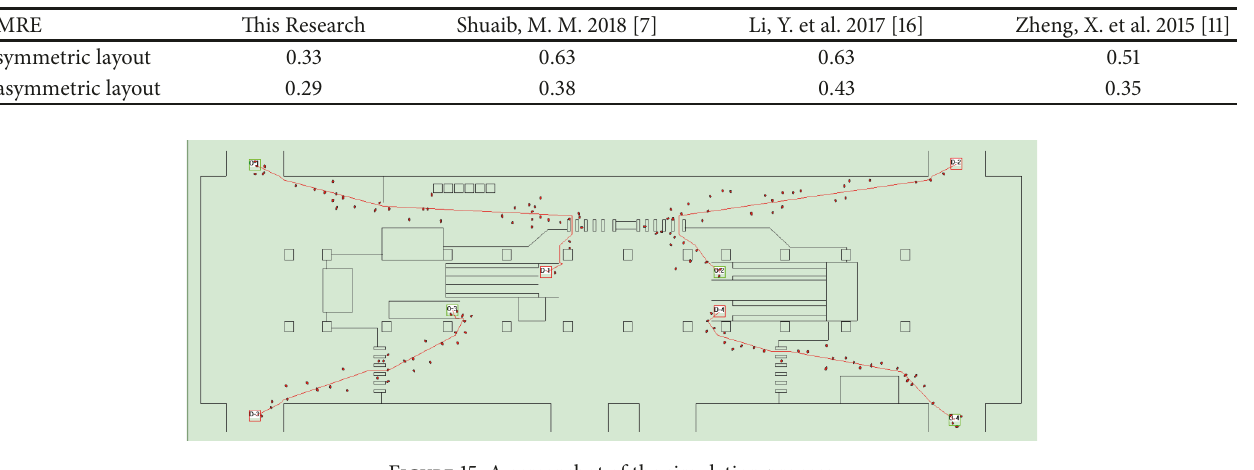
Figure 15: A screenshot of the simulation